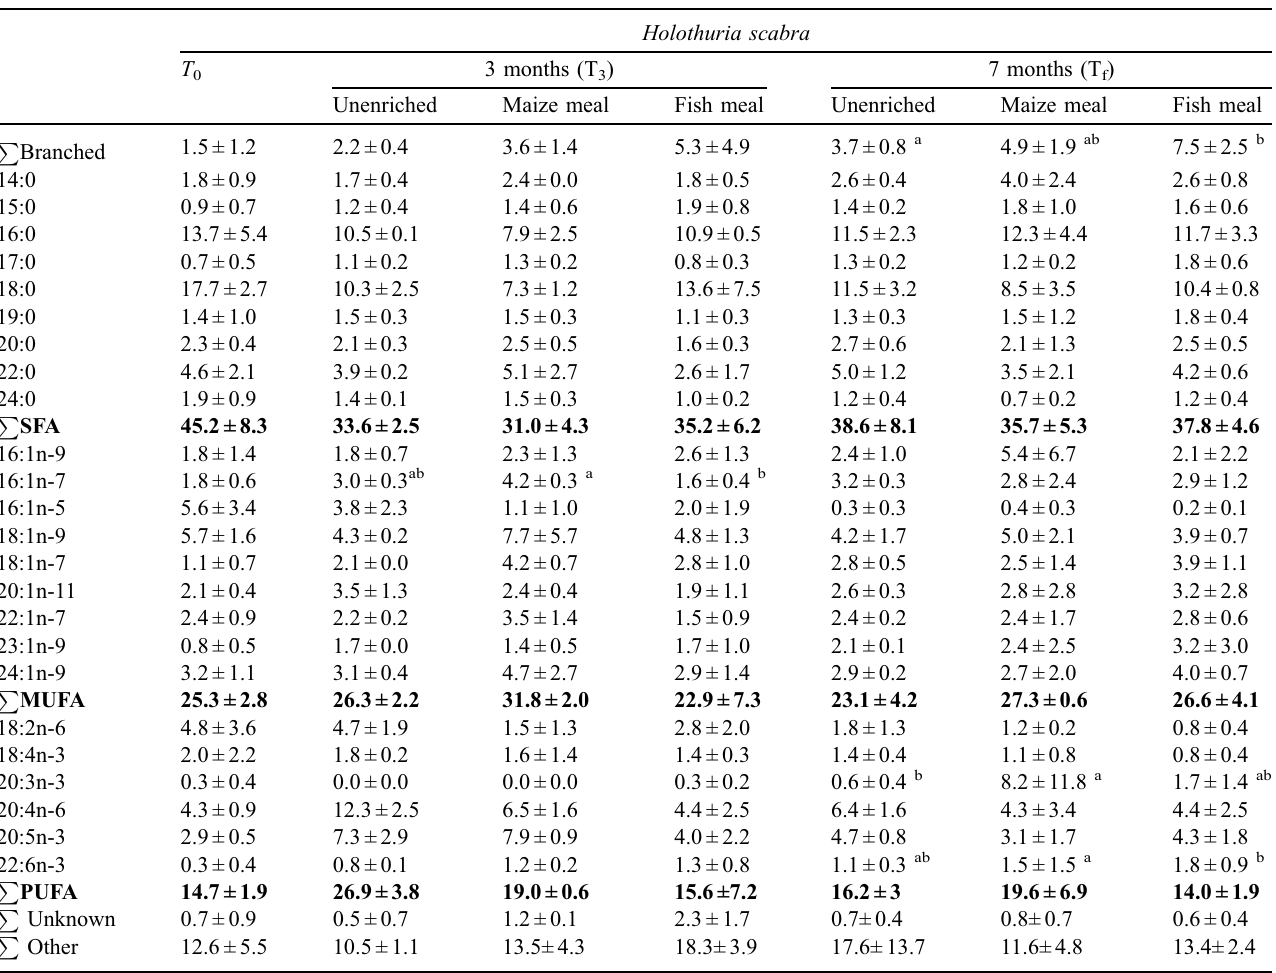
Table 3. Fatty acid composition (mass % of total FA, mean ±S.D.) of the neutral lipids of Holothuria scabra fed the different treatments at the beginning of the experiment (T 0 ) ( n =5), after 3 months ( n = 3 for each treatment) and after 7 months ( n =9 for each treatment). Different letters indicate signi fi cant differences (KW tests followed by Conover-Iman multiple comparison tests with Bonferroni ’ s adjustment method, at signi fi cant level a < 0.05), indicating variations of FA compositions between treatment at 3 months and 7 months. SFA: